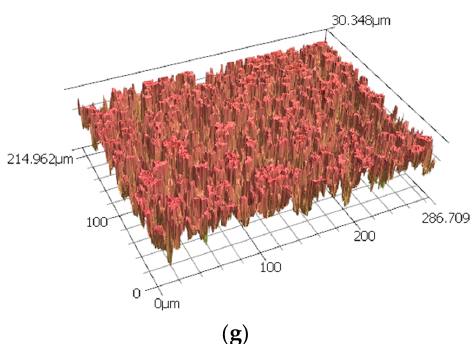
Figure 3. A group of 3D images of the sample surface form 3D LSCM data after ( a ) 0 h, ( b ) 1 h, ( c ) 2 h, ( d ) 6 h, ( e ) 12 h, ( f ) 24 h and ( g ) 48 h of exposure to 0.5 M NaCl media.